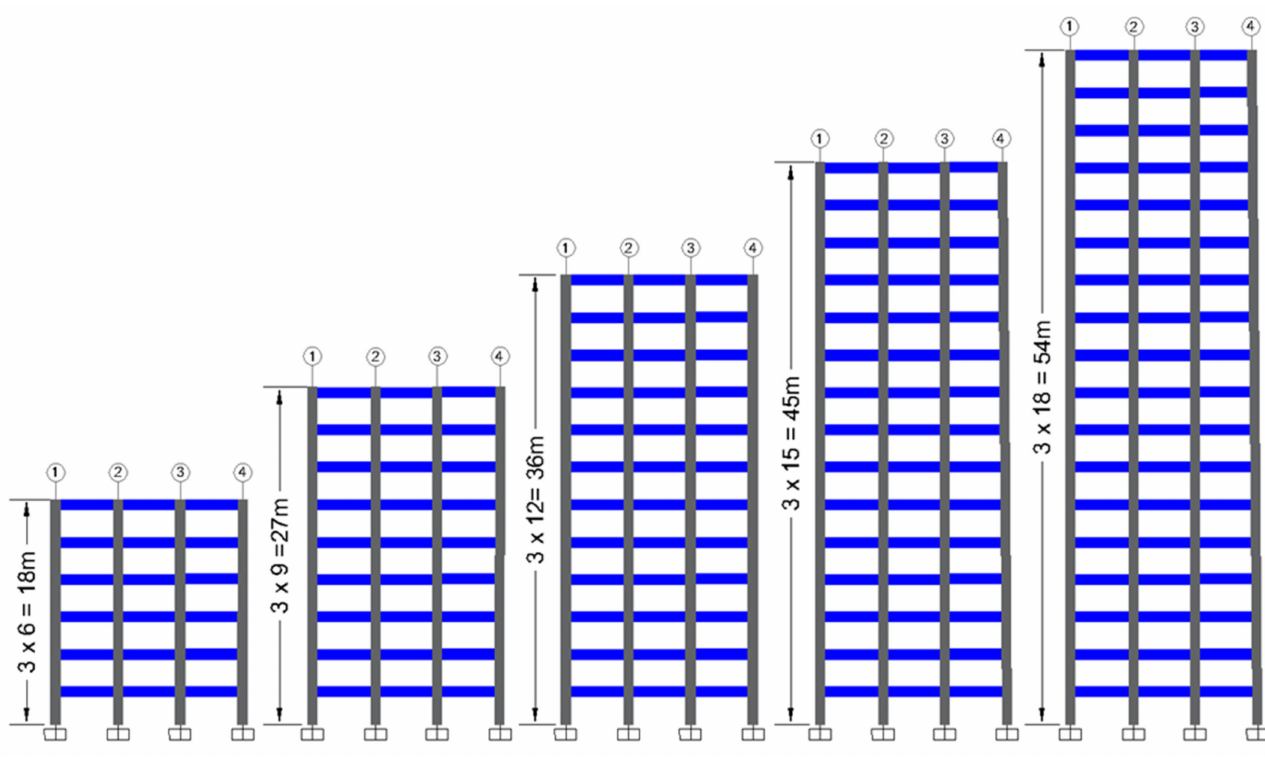
Figure 12. Building models with different heights.